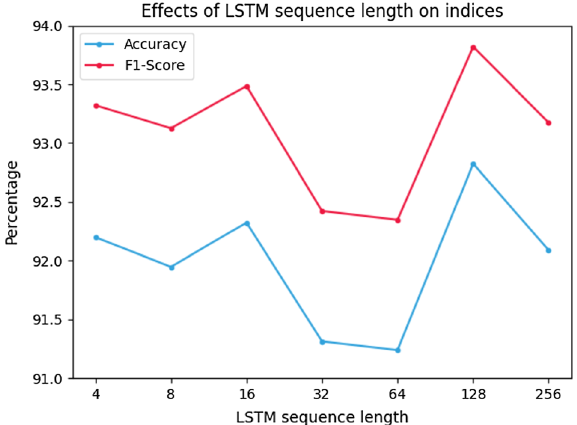
Fig. 10 Performance of the proposed NADLA model with different number of LSTM samples containing original